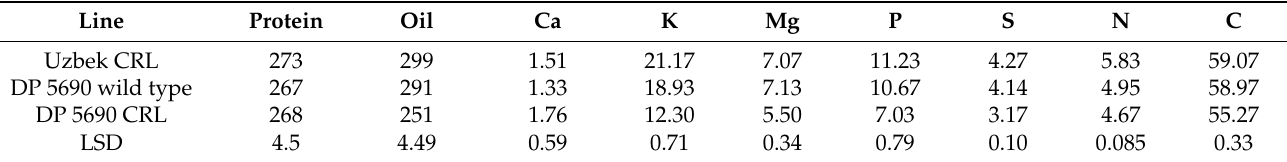
Table 2. Effects of leaf shape trait (curly leaf; CRL) on cottonseed protein and oil (g/kg); calcium (Ca), magnesium (Mg), potassium (K), phosphorus (P), sulfur (S) (mg/g); carbon (C), and nitrogen (N) (%). The experiment was conducted in 2014.